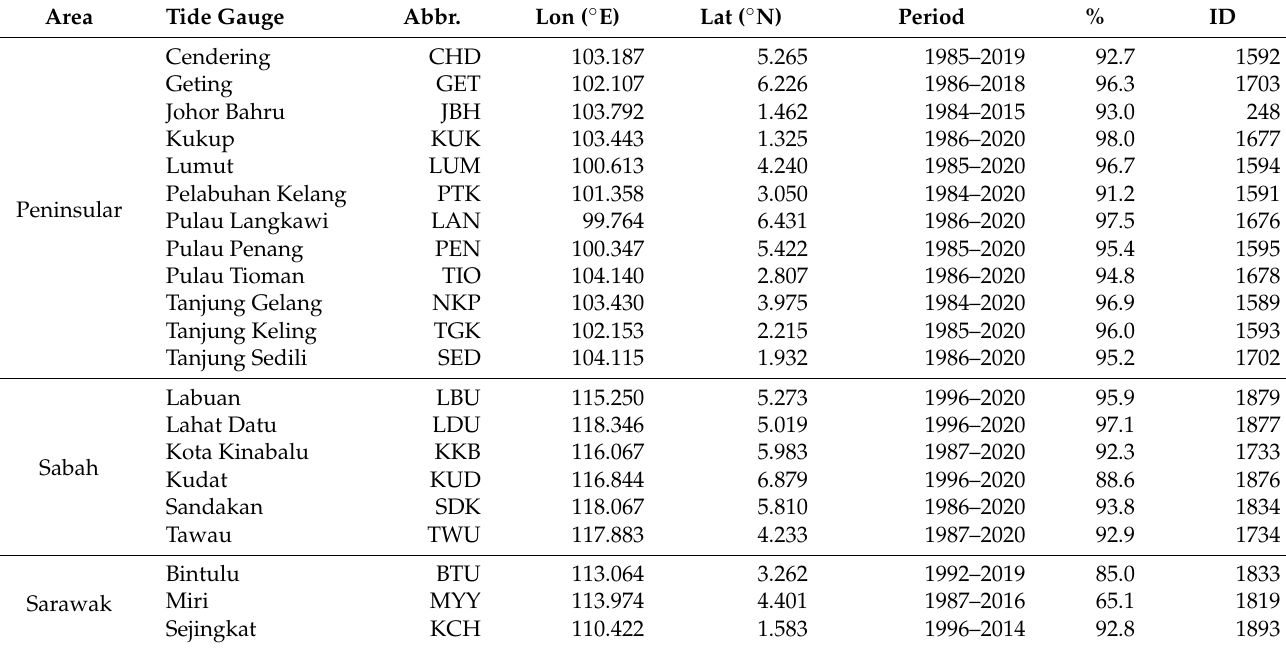
Table 1. The 21 tide gauges in Malaysia analyzed for the study: 12 in Peninsular Malaysia and 9 in East Malaysia. Given are the abbreviations, the geographic coordinates, the data period, the data completeness (in %), and the matching station ID number in the PSMSL